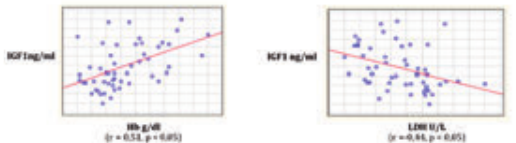
Figura 1. Correlazione tra valori di IGF-1, valori di Hb ed LDH. CONCLUSIONI: Questi dati confermano